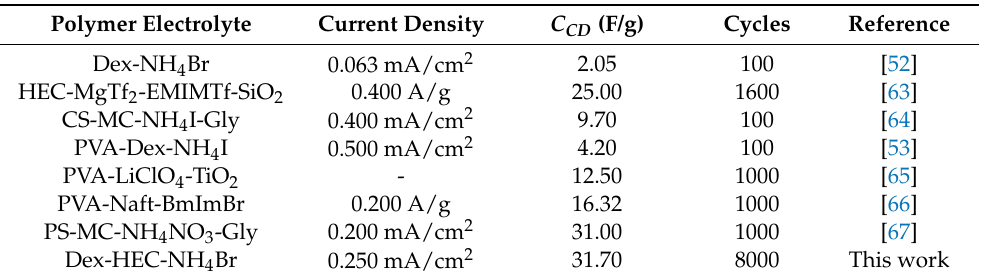
Table 8. Various reported activated carbon-based EDLC studies with their respective value of specific